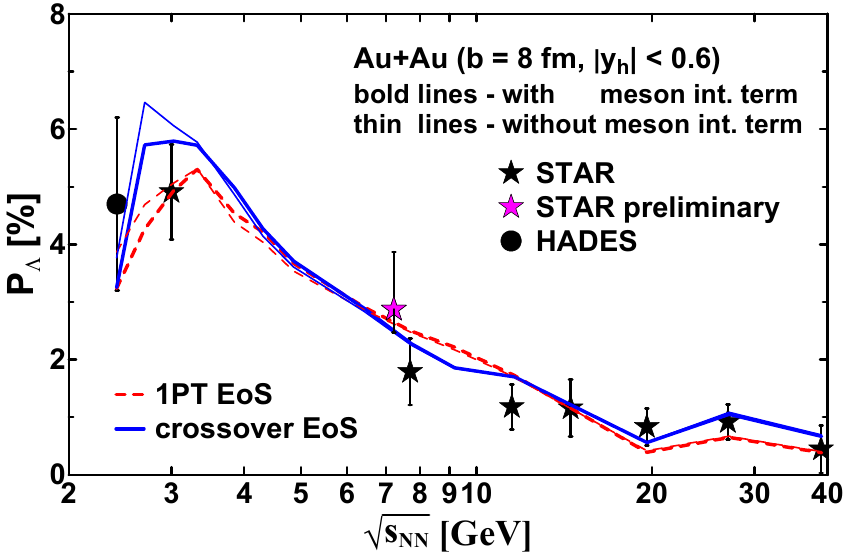
Figure 1. Global Λ polarization in midrapidity regions | y h | < 0.6, originating from the thermal vorticity with (bold lines) and without (thin lines) the meson-field contribution in Au+Au collisions √ s NN . The results for different EoSs are presented. at b = 8 fm as a function of the collision energy Data are from Refs. [28,35,36] (STAR) and [37]